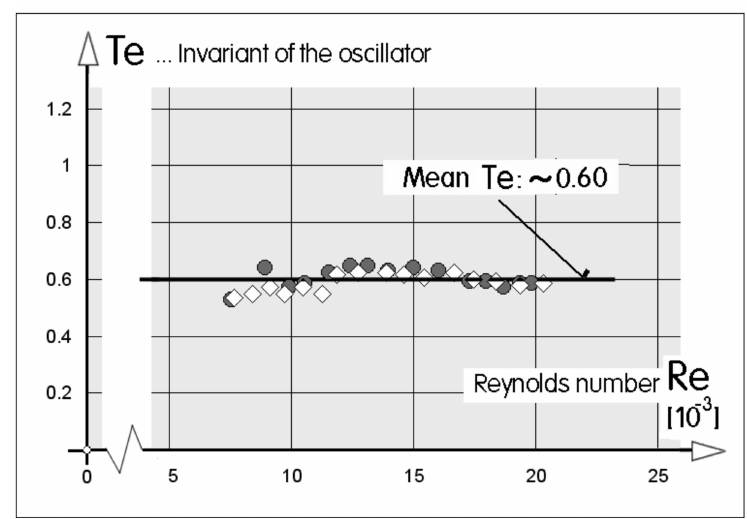
Figure 16. The extremely simple theory of the delay time caused by accelerating the rotation in the vortex chamber results in this invariance of the dimensionless number Te, defined by Equation